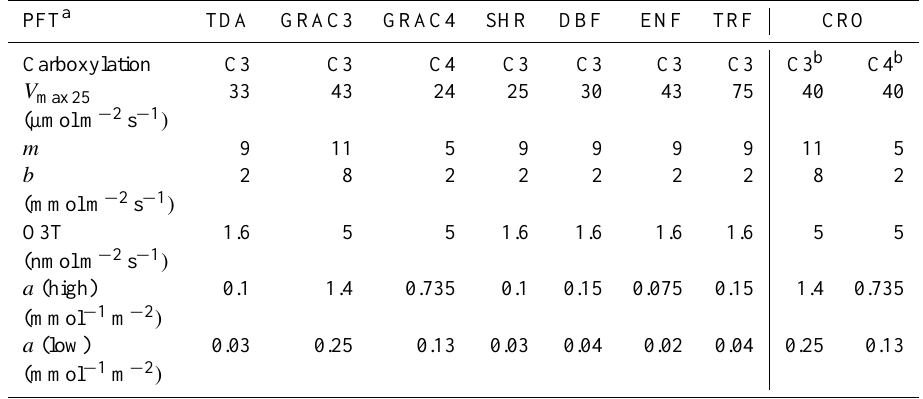
Table 1. Parameters for vegetation model and O 3 damage